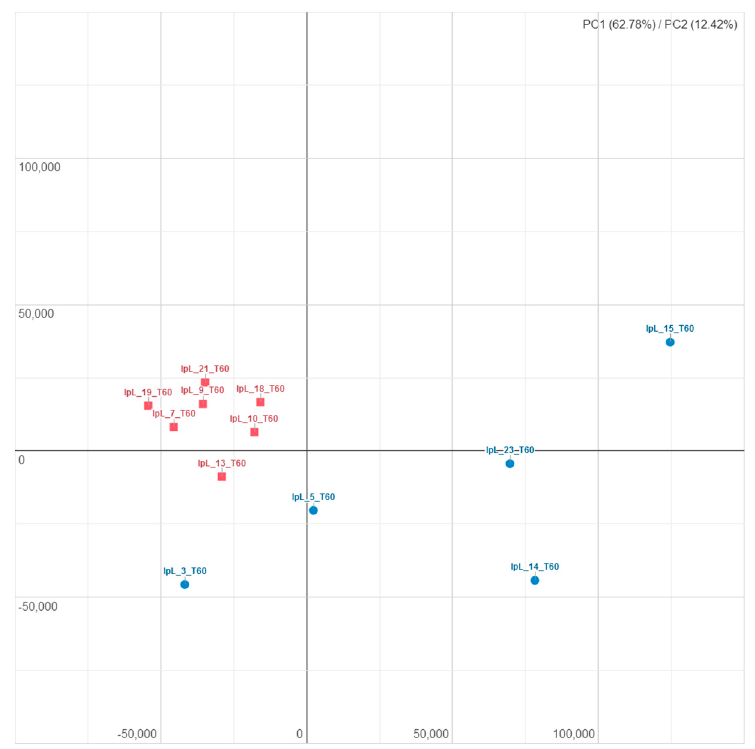
Figure 4. Principal components analysis using the 525 differentially expressed gene identified at the end of the iodine supplementation period: The blue circles identify the iodine samples while the red squares identify CTR samples. Table 2. List of significantly enriched pathways obtained using the downregulated genes following iodine